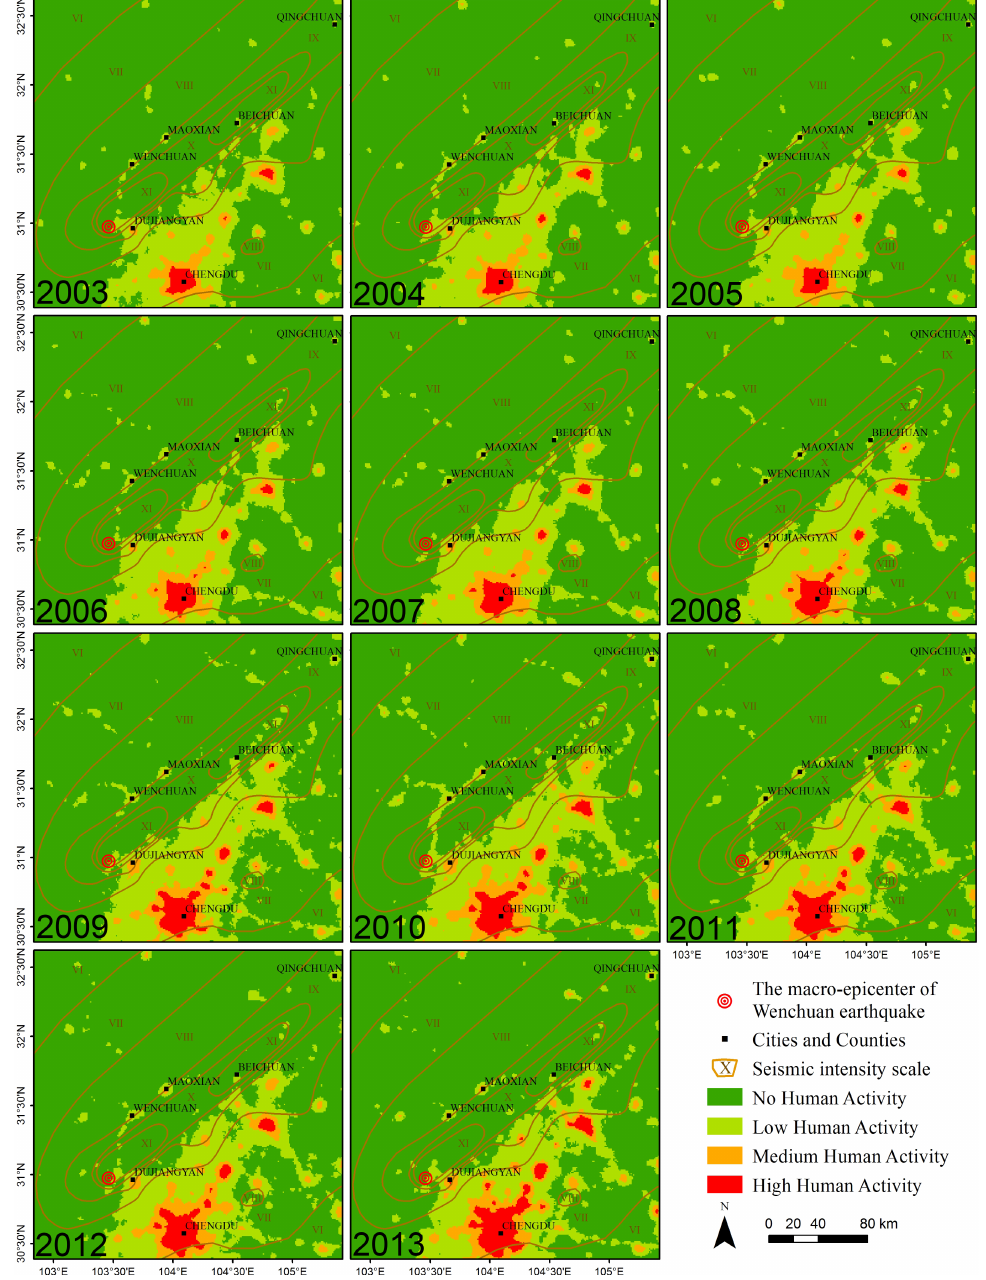
Figure 8. Time series changes of HA levels in seriously-damaged